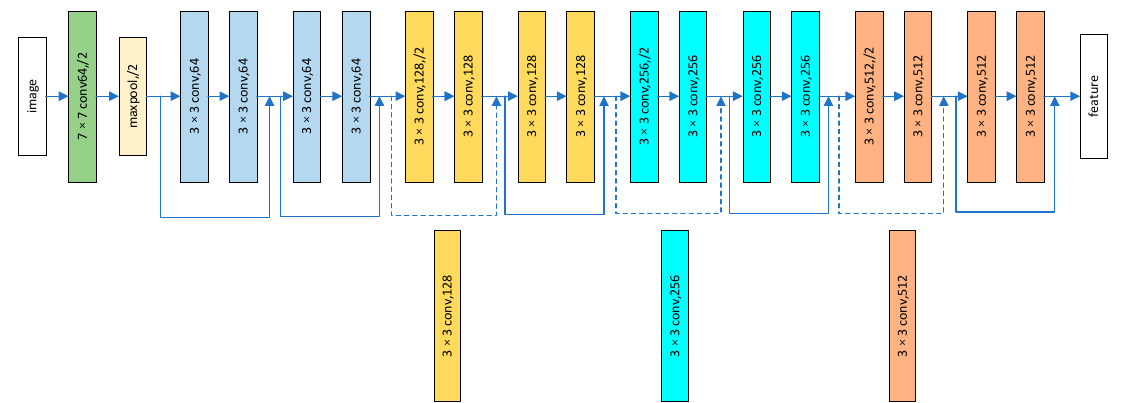
Figure 3. The updated ResNet18. We removed the avg-pool layer and the fully connected (FC) layer to facilitate the next step of feature fusion.